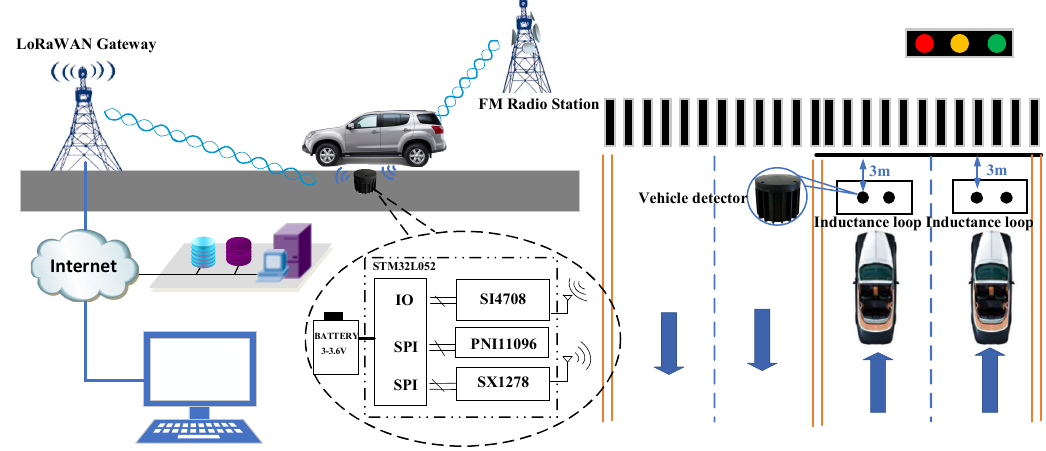
Figure 1. Vehicle detection system architecture and installation diagram.